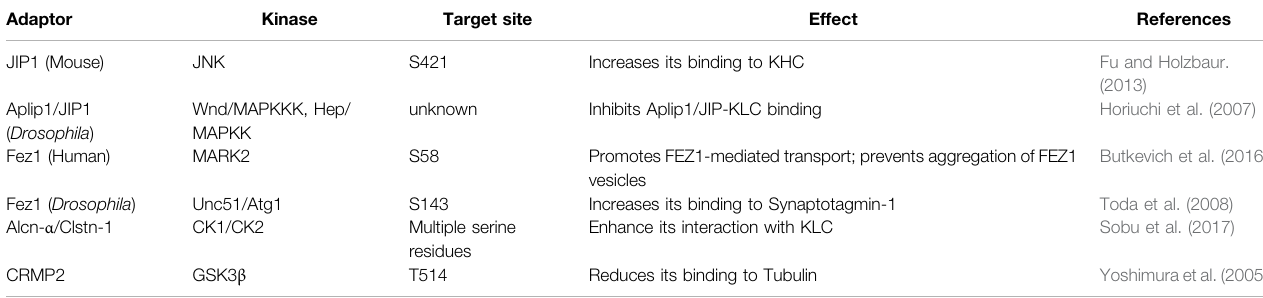
TABLE 2 | List of phosphorylation targets of kinesin